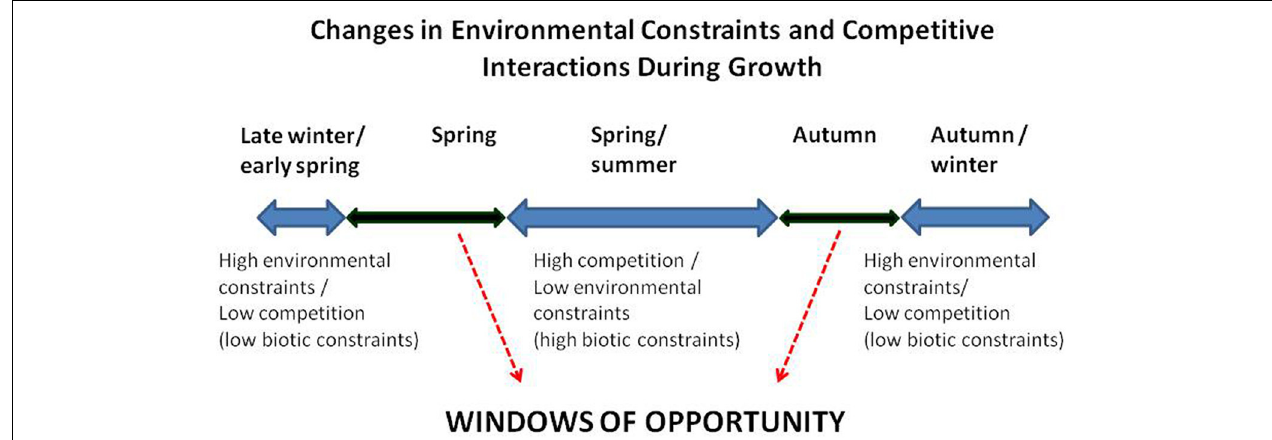
FIGURE 1 | Diagrammatic representation of changes in environmental constraints and competitive interactions during vegetative growth and development over the course of a year. Note that in spring and, to some extent, in autumn, competition will be low, although there could be high to moderate environmental constraints to growth and development that could impact on any introduced alien plant species. At other times, competitive interactions will be high, with the possibility of biotic constraints associated with near optimal environmental conditions during the main growth period. The “windows of opportunity”, designated by black arrows, represents